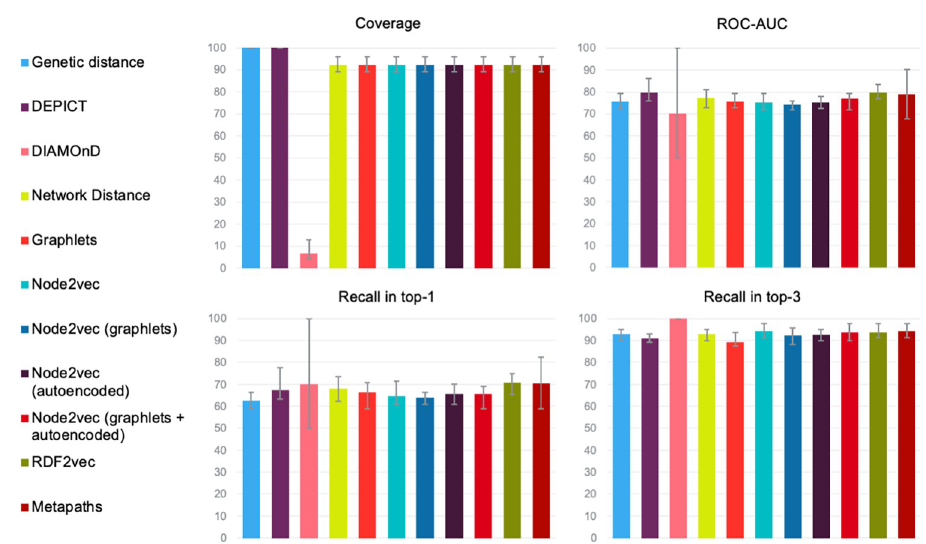
Fig 2. Average performance for different metrics, achieved by the best individual methods for identifying genes targeted by disease-associated non-coding SNPs. The x-axes list the different methods from left to right (the colours from left to right corresponding with those at the left listed from top to bottom), while the y-axes represent each of the four performance metrics as percentages ranging from 0% to 100%. Error bars indicate the range of the performances of the respective methods across the four reference sets.